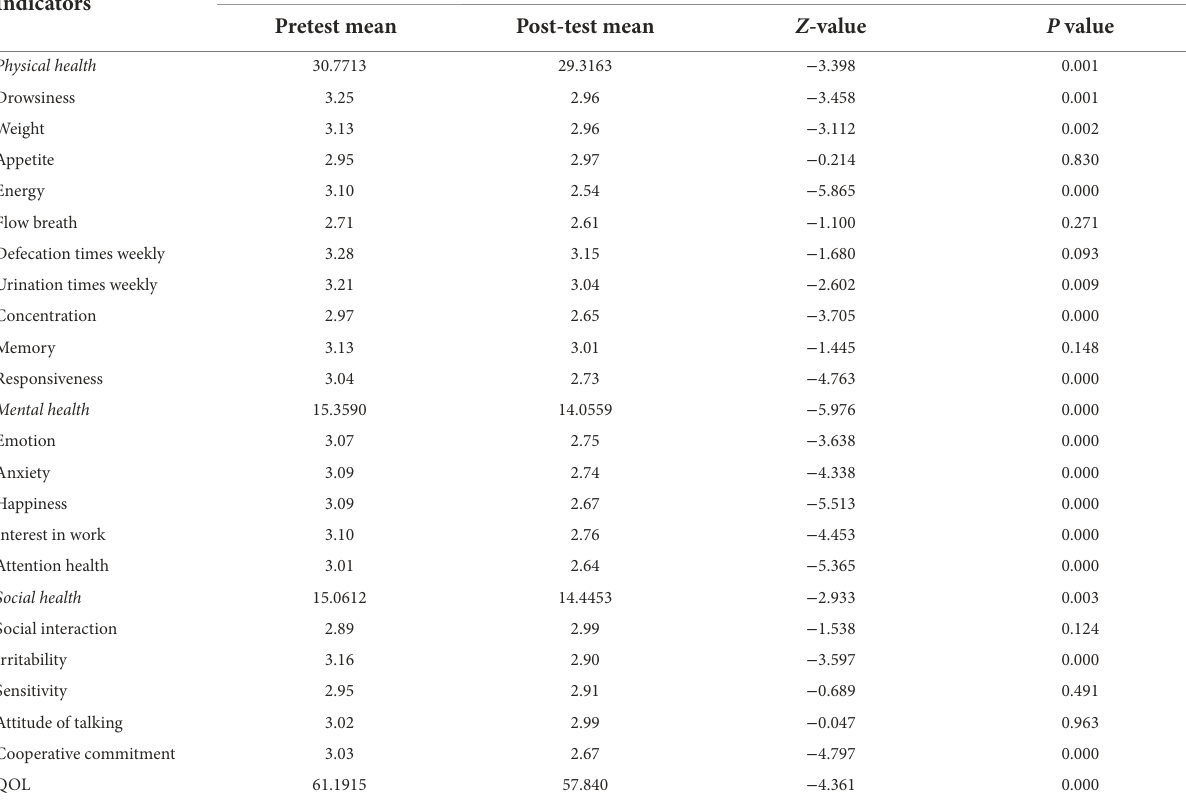
Observation group